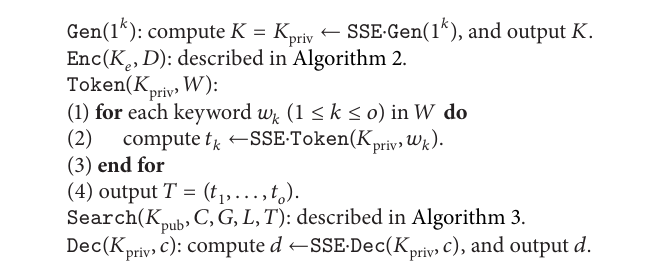
Algorithm 4: LSE scheme: symmetric